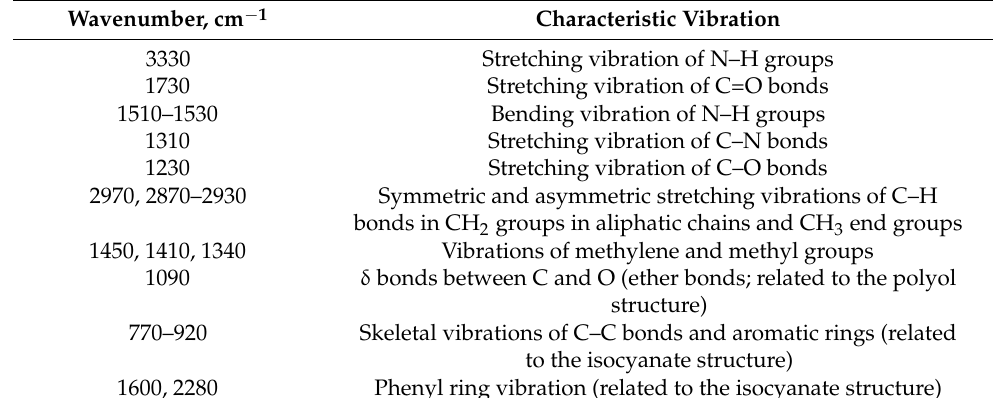
Table 3. Absorption bands of the PUR structure [22,42–45].